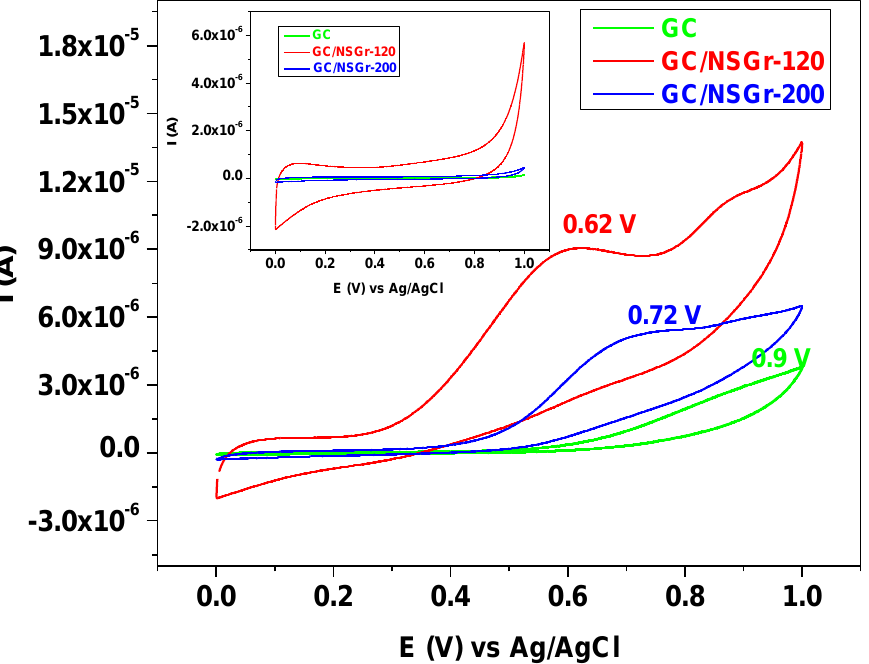
Figure 10. Cyclic voltammograms recorded with bare GC (green), GC/NSGr-120 (red), and GC/NSGr-200 (blue) in solution containing 10 − 3 M L-cysteine (pH 6 PBS supporting electrolyte). The inset shows the CVs recorded with each electrode in pH 6 PBS electrolyte.